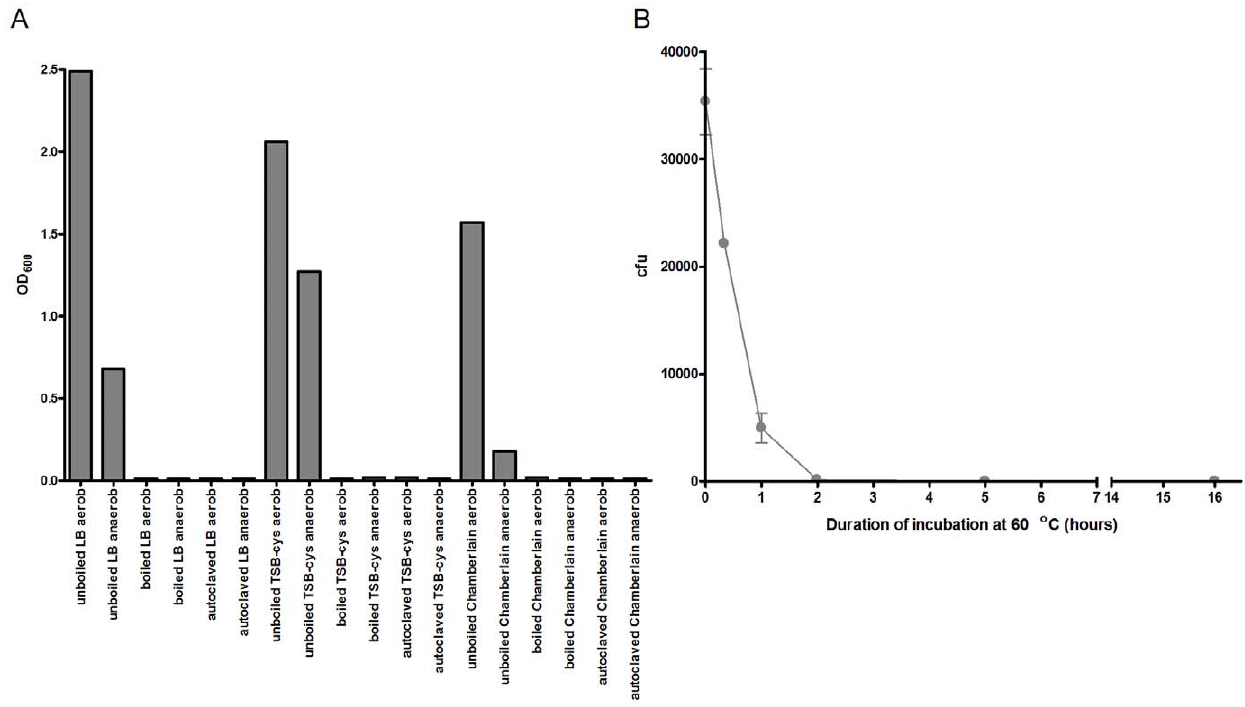
Figure 2. Heat sterilization of human feces. A) Human fecal aliquots, dispensed in vials, were either autoclaved or placed in a boiling water bath then used as inoculum for liquid cultures incubated aerobically or anaerobically, as described in Materials and Methods. While untreated (not autoclaved or boiled) fecal samples display growth in all three media compositions (LB – Luria Bertani media, TSB-cys – tryptic soy broth + 0.1% cysteine media, Chamberlain – Chamberlain media) and culturing conditions, autoclaving or boiling the samples abolishes growth. Reported values are average of duplicates. B) Aliquots of a human fecal sample were incubated at 60 u C for the indicated duration then used as inoculum for LB-agar plates, as detailed in Materials and Methods. A plot of colony forming units (cfu) as a function of incubation duration illustrates the loss of enteric microbial viability over the first hour of 60 u C incubation, with no growth observed after 2 hours and beyond. The experiment was performed in